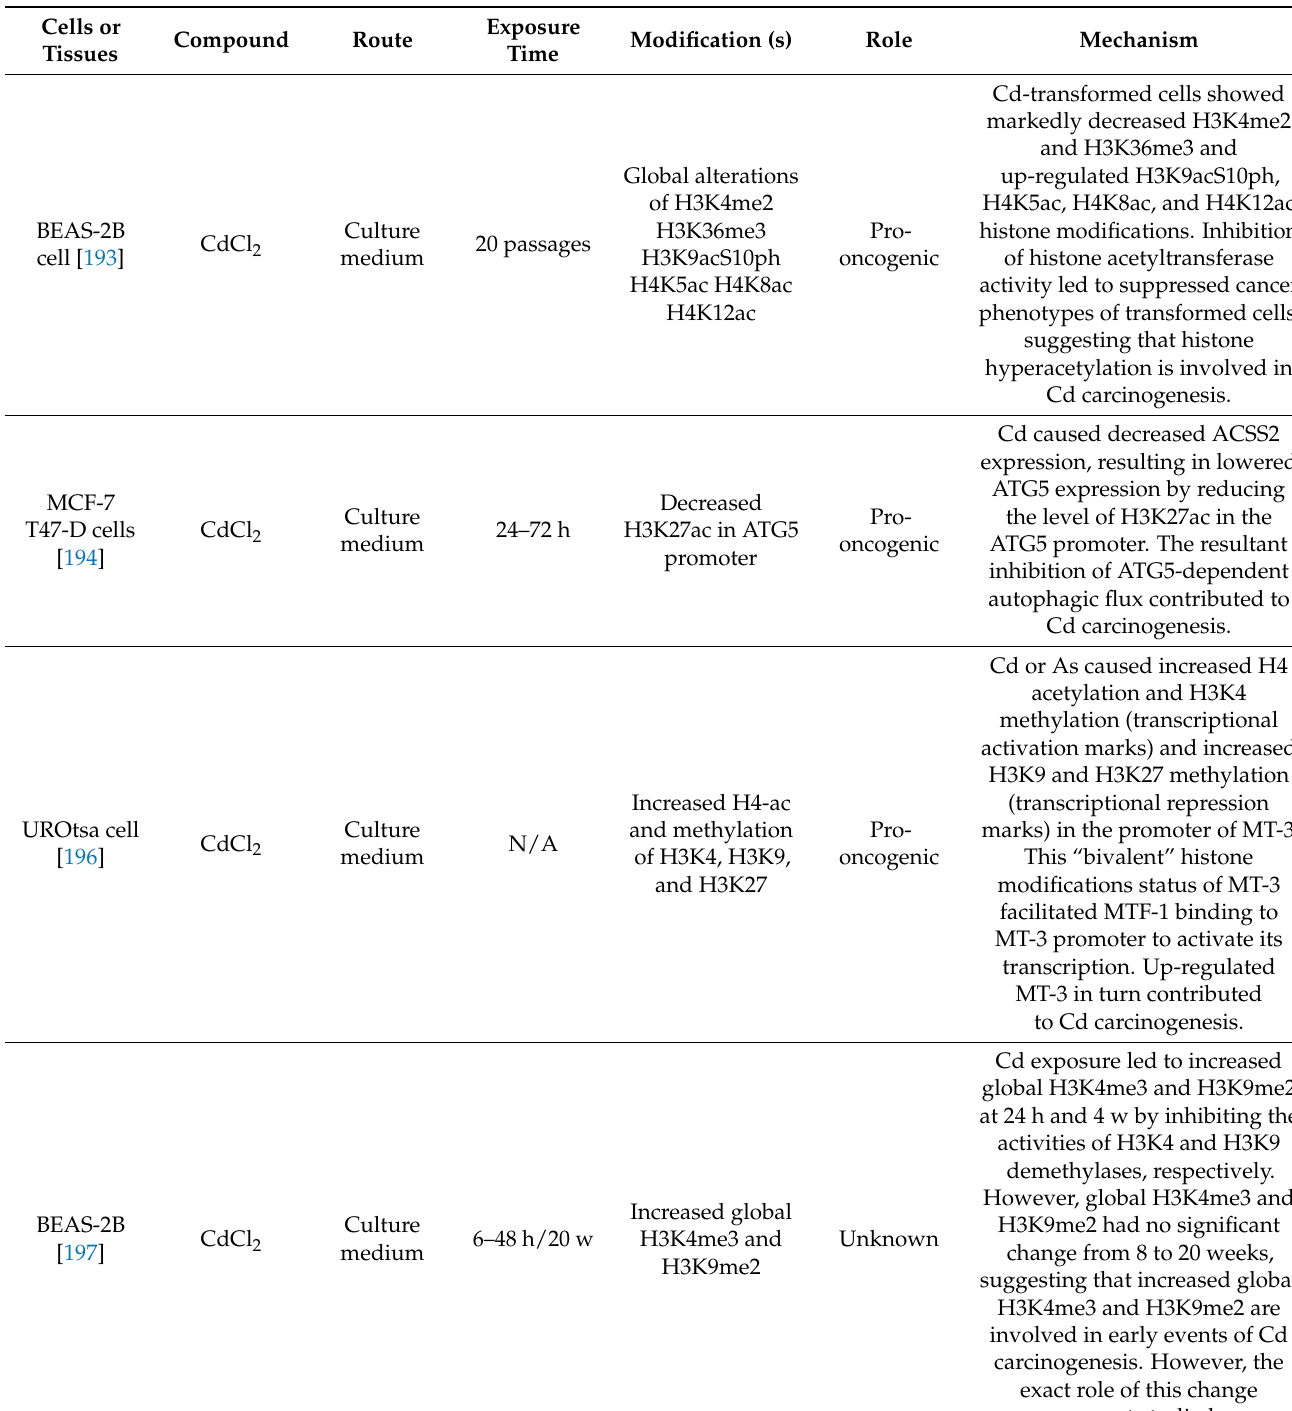
Table 8. Roles of altered histone modifications in Cd-induced